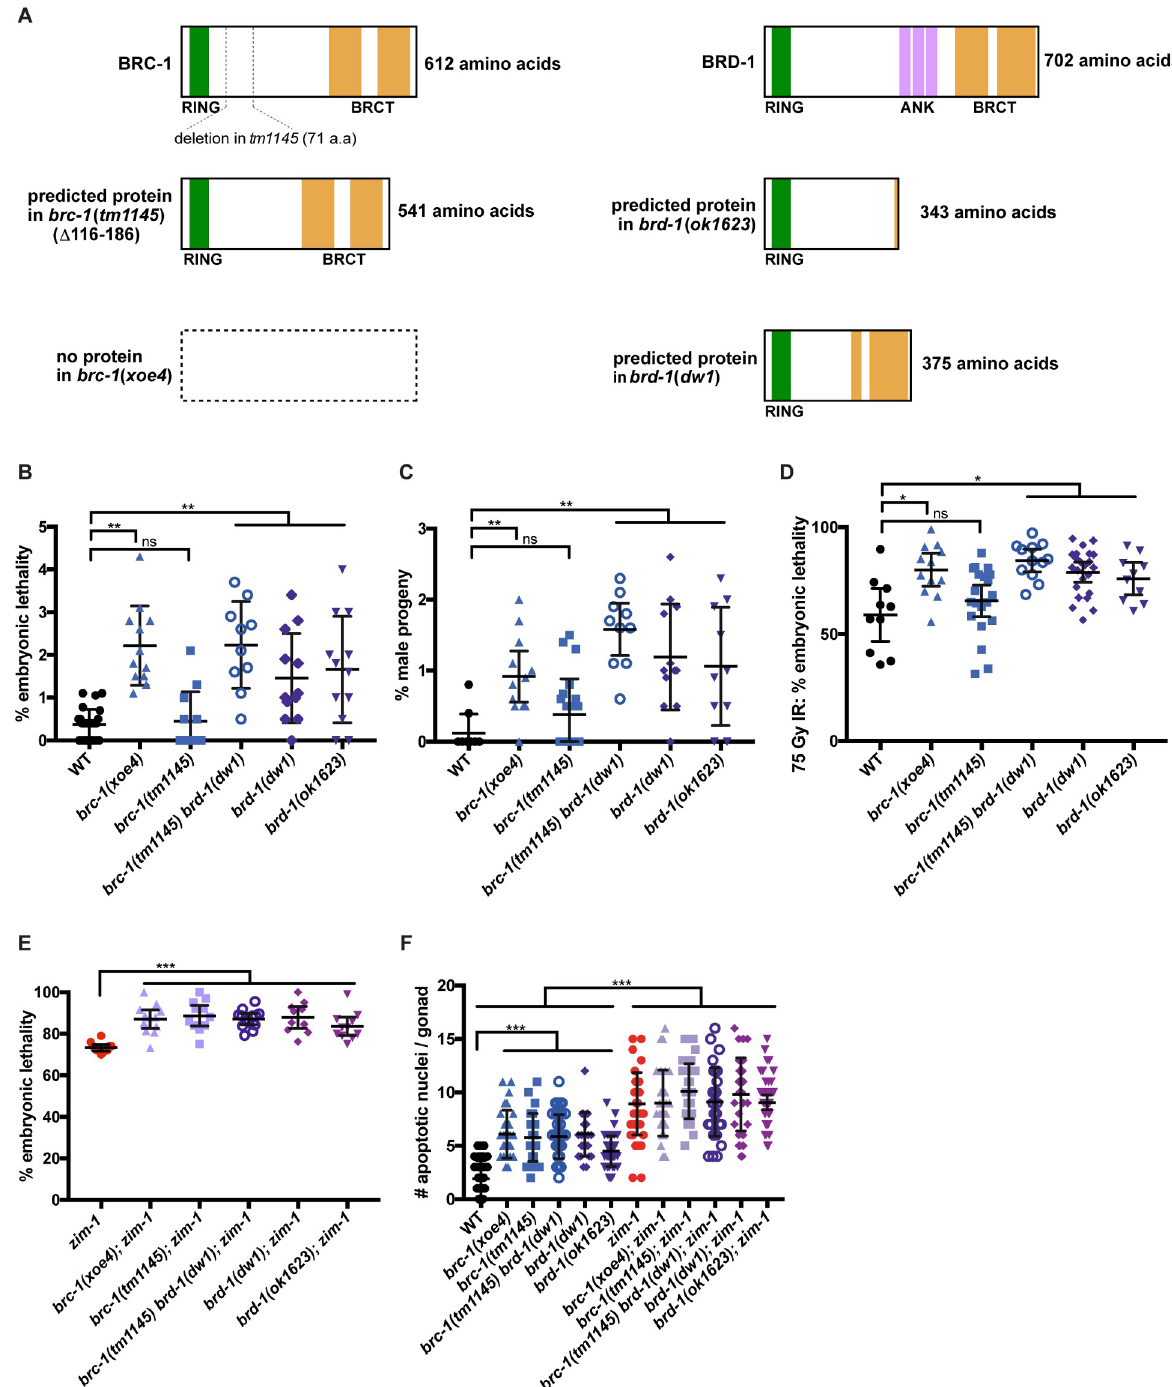
Fig 5. Differential effect of brc-1 and brd-1 alleles on the DNA damage response and meiosis. A) Cartoon of predicted proteins produced from the different brc-1 and brd-1 mutant alleles based on cDNA analysis (see also S3A Fig). RING (green), BRCT (gold) and Ankyrin (ANK; purple) domains are indicated. B) % embryonic lethality of brc-1 and brd-1 mutants; numbers of animals scored: WT = 26; brc-1(xoe4) = 12; brc-1(tm1145) = 12; brc-1(tm1145) brd-1(dw1 ) = 10; brd-1(dw1) = 12; brd-1(ok1623) = 12. C) % male progeny produced from brc-1 and brd-1 mutants; numbers of animals scored: WT = 10; brc-1(xoe4) = 12; brc-1(tm1145) = 22; brc-1(tm1145) brd-1(dw1 ) = 10; brd-1(dw1) = 12; brd-1(ok1623) = 10. D) % embryonic lethality following 75 Gy IR; numbers of animals scored: WT = 10; brc-1(xoe4) = 12; brc-1(tm1145) = 20; brc-1(tm1145) brd-1(dw1 ) = 12; brd-1(dw1) = 23; brd-1(ok1623) = 10. E) % embryonic lethality of zim-1 in the presence and absence of BRC-1-BRD-1. Numbers of animals